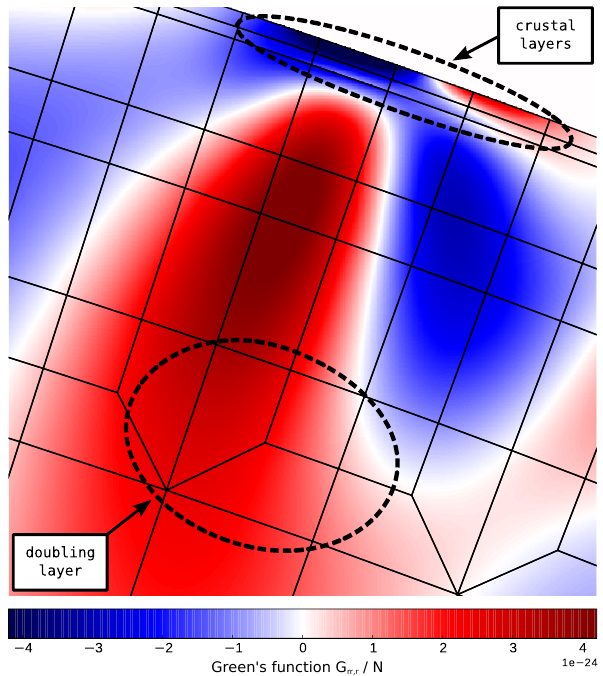
Figure 5. Snapshot of one component of the Green’s tensor ( G rr,r ) as represented in the SEM basis for a shortest period of 50s. Discon- tinuities such as caused by the crustal layers are exactly represented and the wave field is smooth across doubling layers of the